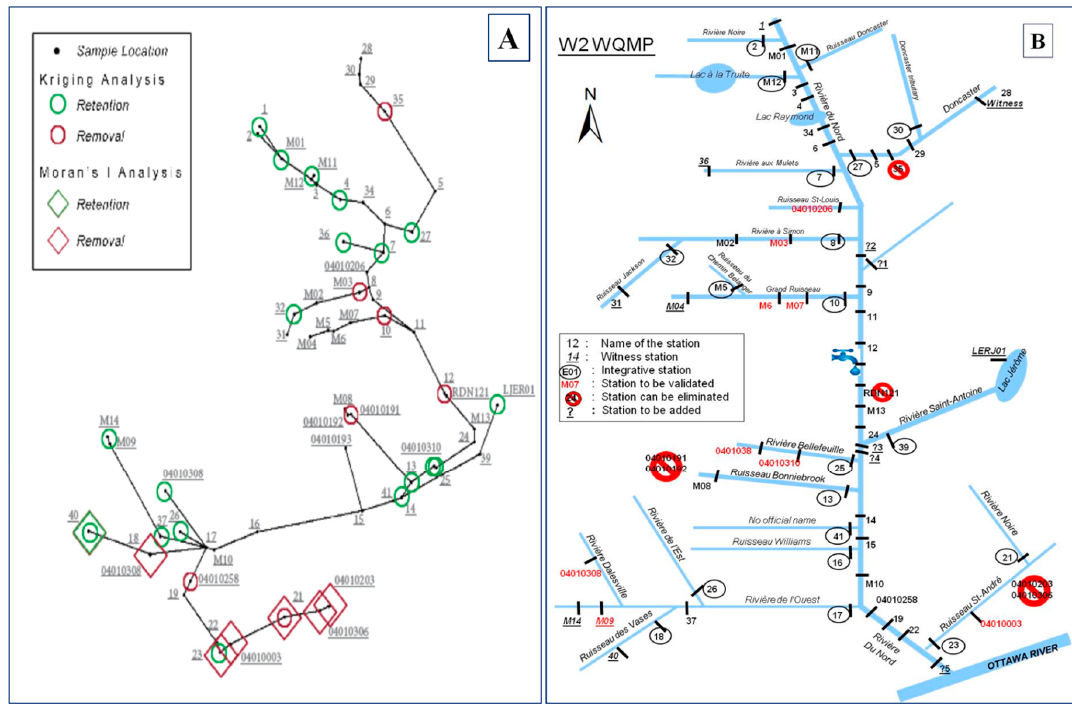
Figure 10. ( A ): illustrates the W2 sampling site network, the sampling site network, and the sampling stations suggested for retention or removal following the Kriging and Moran analysis. Stations without